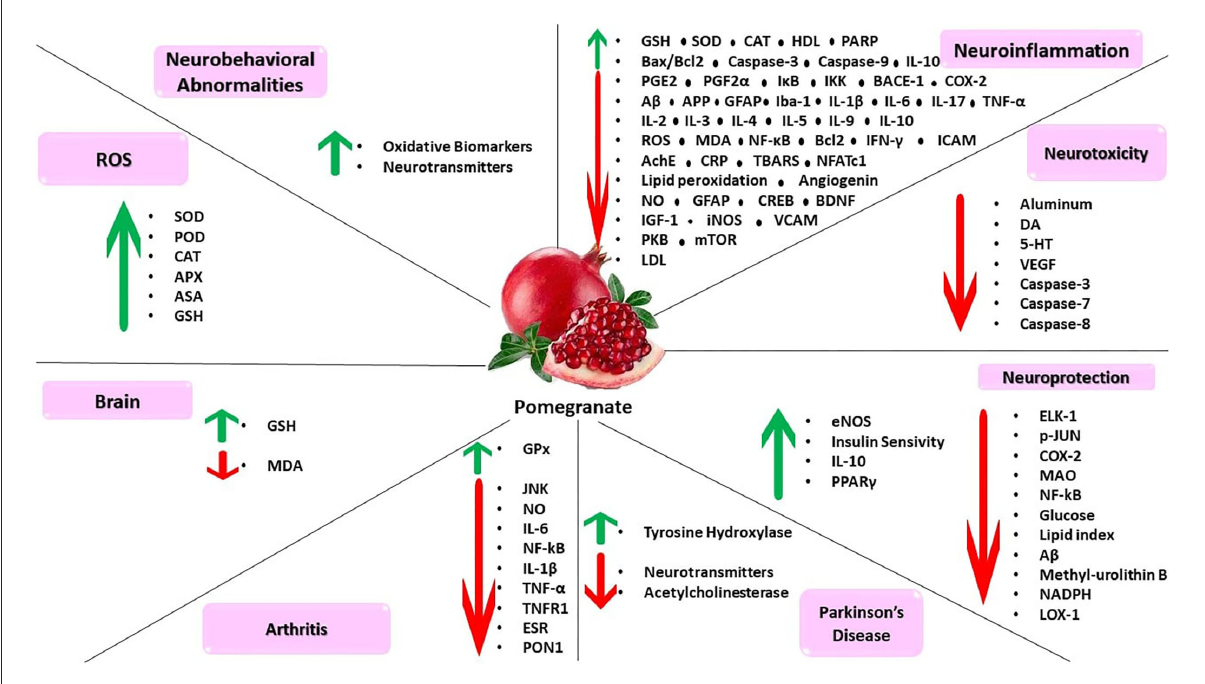
FIGURE3 Pomegranate can inhibit neuroinflammation, neurotoxicity, and ROS. This compound has protective agents for brain and age-related neurological disorders such as Parkinson’s disease, arthritis, neurobehavioral abnormalities.